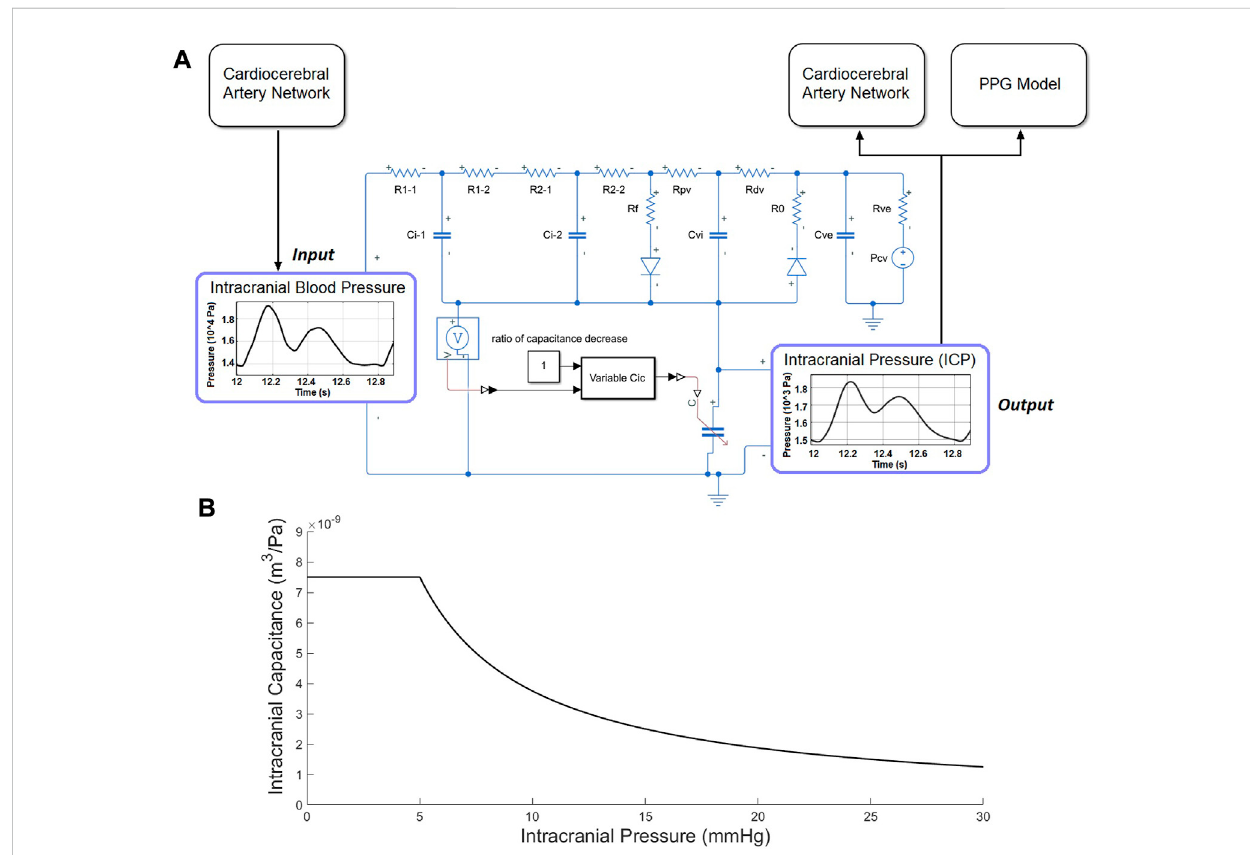
FIGURE 3 ICP model. (A) Electric analog of the human intracranial hydrodynamics for ICP simulation. R1-1, R1-2, and Ci-1: hydraulic resistance and compliance of the proximal arterial cerebrovascular bed (basal brain arteries and large pial arteries), respectively; R2-1, R2-2, and Ci-2: hydraulic resistanceandcomplianceofthedistalarterialcerebrovascularbed(mediumandsmallpialarteries),respectively;Cic:intracranialtissuecompliance;Cvi: intracranialvenouscompliance;Rpv:hydraulicresistanceoftheproximalvenouscerebrovascularbed;Rdv:hydraulicresistanceofthedistalvenous cerebrovascular bed (lateral lacunae and bridge veins); Rf: CSF formation resistance; Ro: CSF out fl ow resistance; Rve and Cue: hydraulic resistance and compliance of the extracranial venous pathways; Pcv: central venous pressure. (B) The piecewise function between ICP and intracranial